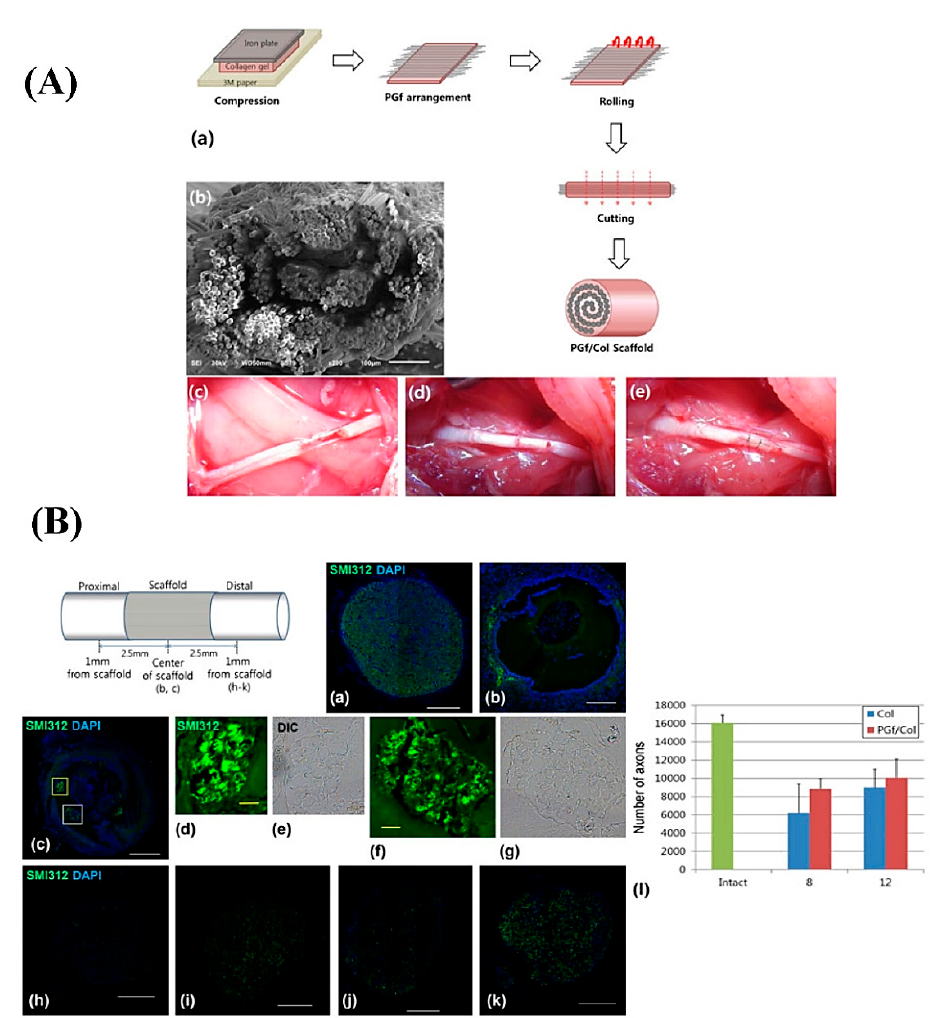
Figure 3. ( A ) Composite scaffolds of phosphate glass fibers (PGfs) and collagen (Col) designed for peripheral nerve regeneration: (a) and (b) demonstrate the manufacturing process of the scaffolds and their scanning microscopy (SEM) photographs (scale bar = 100 µm). (c), (d), and (e) show the surgery procedure related to complete transection of the sciatic nerve, the implantation of the composites (0.8 mm diameter, 3 mm long), and suturing of the neural sheath with 10-0 nylon suture, respectively. ( B ) Illustration of immunohistological staining of animal axons within the (a) cross-section of an intact sciatic nerve; (b) cross-section of the scaffold collagen group; and (c) PGf/collagen scaffolds at 7 days post-surgery. (d) and (e) exhibit magnified images of the yellow boxes in (c). (f) and (g) represent high-magnification images of the white boxes in (c) (white scale bar = 200 µm, yellow scale bar = 20 µm). Cross-sectional images 1 mm distal from (h) the collagen group and (i) the PGf/collagen group at 8 weeks post-implantation, and (j) the collagen group and (k) the PGf/collagen group after 12 weeks. (l) shows the number of axons at 1 mm distal to the scaffolds 8 and 12 weeks post-implantation. DIC: differential interference contrast microscope. DAPI: 4 ′ ,6-diamidino-2-phenylindole. Reproduced with permission from ref [24].